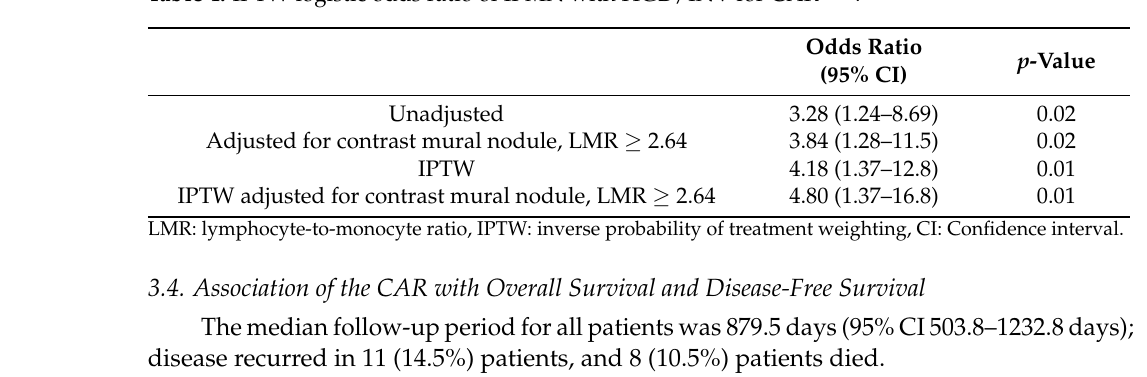
Table 4. IPTW logistic odds ratio of IPMN with HGD/INV for CAR high